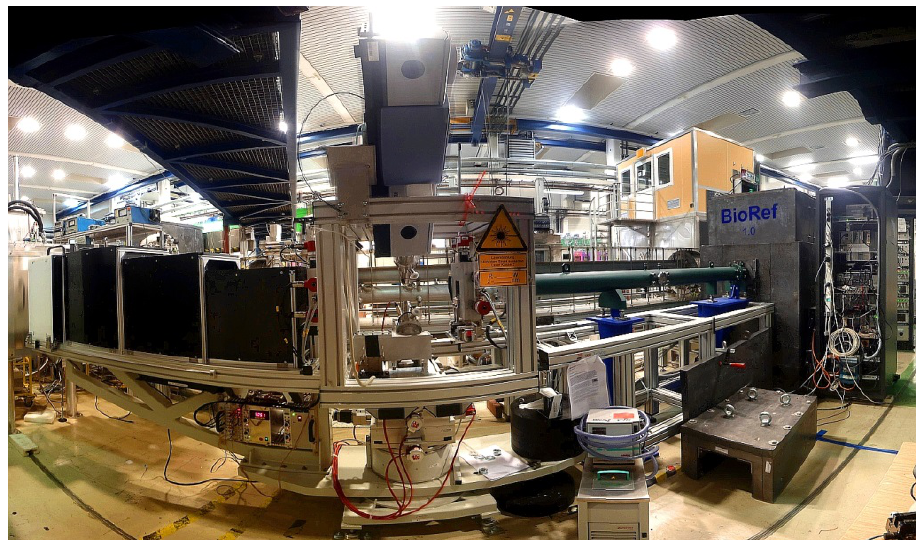
Figure 1: View of V18.